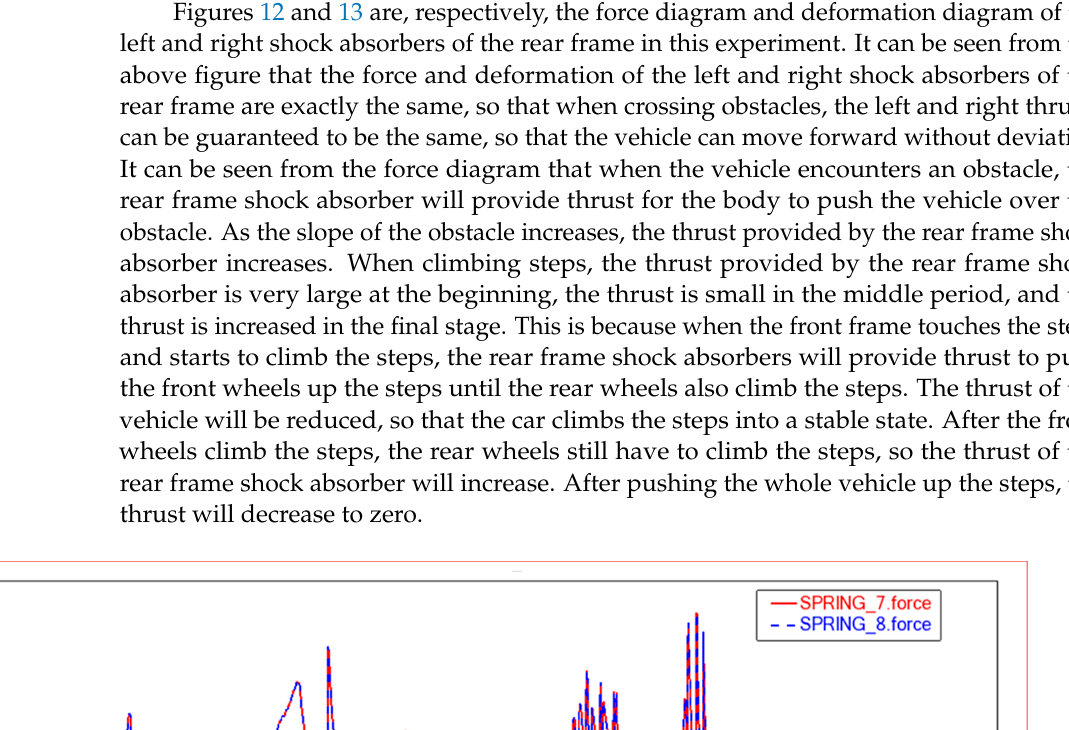
Figure 13. Deformation diagram of rear frame shock absorber in Experiment 1. SPRING-7-Rear frame left shock absorber; SPRING-8-Rear frame right shock absorber. As shown in Figure 14, the mass center speed of the front frame and the rear frame is compared in this experiment. When the car crosses obstacles, compared to the plane motion, the speed changes mainly on the z-axis. It can be seen from Figure 14a that the speed of the z-axis is 0 when the car is moving in a plane. When climbing obstacles, the speed of the z-axis increases. As the road surface fluctuates, the speed of the z-axis changes continuously. The middle curve is the speed change curve when the car passes through the semicircular boss. The wheels move along the arc road. When climbing the front semicircle, the speed is first fast and then slow. The third curve is the speed change curve when the car climbs the steps. Because the characteristic of the steps is to move upwards and then move in a plane, there is a sawtooth speed fluctuation when climbing the steps. Because there are seven steps in total, the speed fluctuates seven times. The speed curve of the rear frame is similar to that of the front frame, but lags behind the front frame in time.